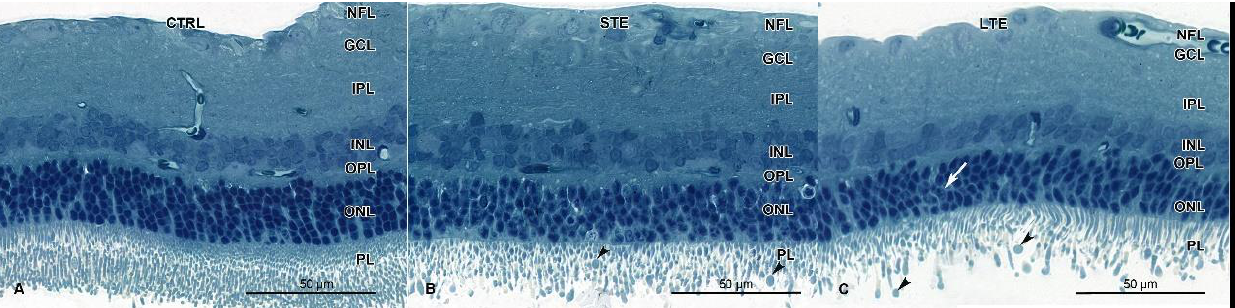
Figure 5. Effect of blue light exposure on the retinal morphology of Wistar rats. The rats were exposed to 12 h white light (150 lx) and 12 h darkness for 10 d (control, CTRL; 9 rats), cycles of 12 h blue light (150 lx) and 12 h darkness for 10 d (long-term exposure, LTE; 9 rats), and constant blue light (150 lx) for 2 d (short-term exposure, STE; 9 rats). Resin-embedded semi-thin sections were stained with toluidine blue. Retinas from the control group ( A ) display normal morphology. Retinas from the STE ( B ) and LTE ( C ) groups show loss of photoreceptor outer segments and their vesiculation (arrowheads). Note signs of apoptosis (chromatin pyknosis and apoptotic bodies) are present in some nuclei of the outer nuclear layer of the LTE group (white arrow). Samples were visualized and photographed with a light microscope (Axioimager,